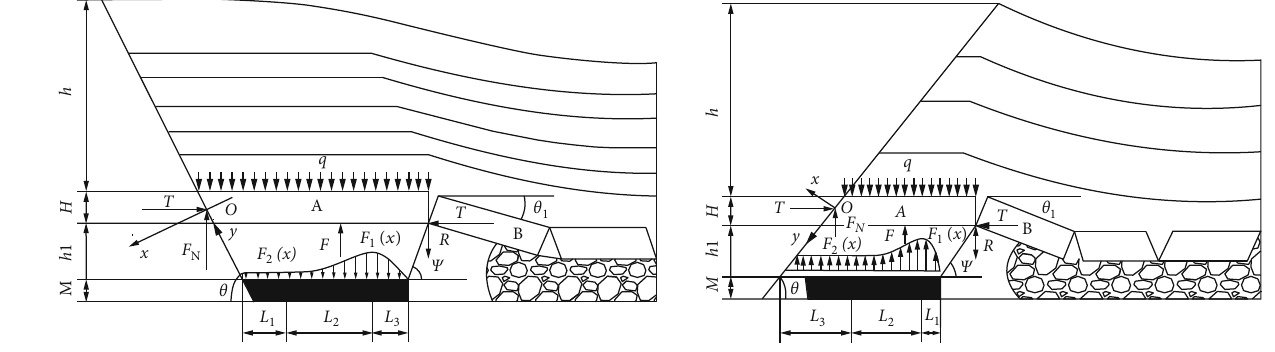
Figure 1: Movement of key strata when mining on hanging-wall and foot-wall [6].